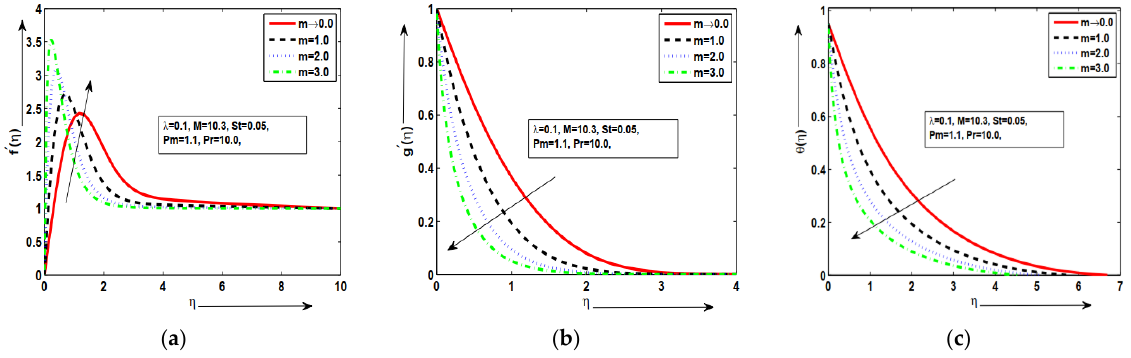
Figure 2. ( a – c ) The geometric profiles of f (cid:48) ( η ) , g (cid:48) ( η ) , and θ ( η ) against m .